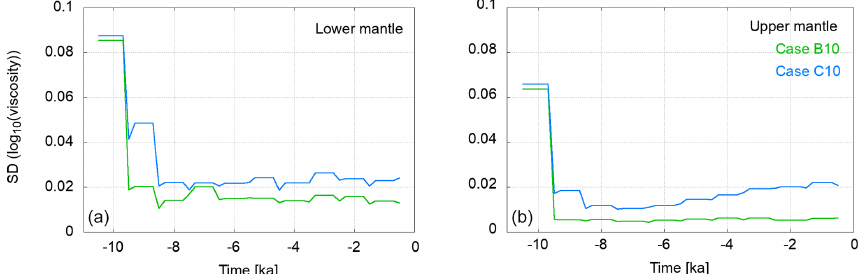
Figure 19. Variation in the ensemble standard deviation of log 10 (ν) over time for the 10kyr assimilation (green – Case B10; blue – Case C10). Panel (a) shows the values for the lower mantle, and panel (b) shows the values for the upper mantle, respectively. The points at the beginning and end of each plateau represent the ensemble at the beginning and end of a forecast phase. They are equal since, during the forecast, the viscosity remains unchanged. The drop after a plateau happens due to resampling and the subsequent rise due to perturbation (although this happens at the same point in time, the values are shifted horizontally to visualise the